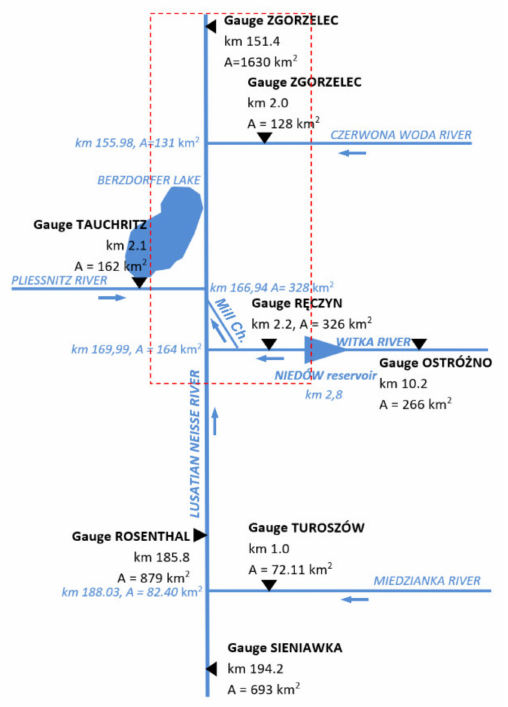
Figure 10. Hydrological scheme for the modeled domain (the dashed line indicates part of the 2D